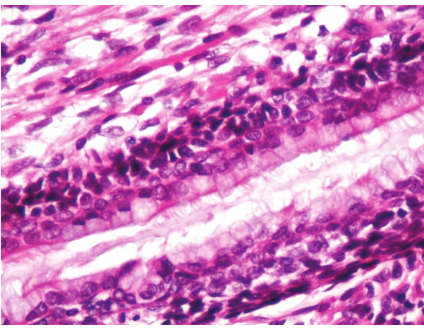
Figure 6: Ciliated columnar epithelium lining the microcyst and underlying condensation of small round cells. H&E: ×